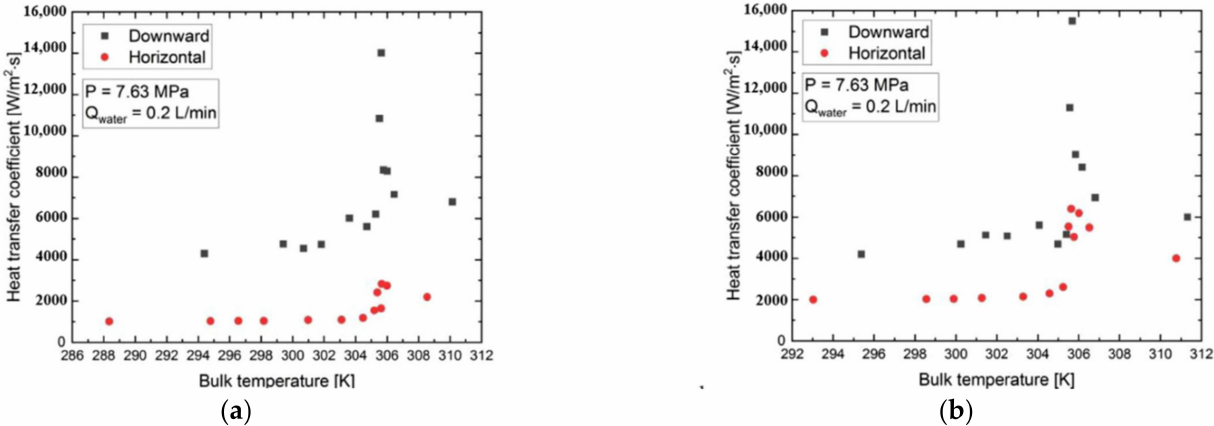
Figure 11. Heat transfer coefficient in different flow directions [38]; ( a ) m CO2 ≈ 1.323 kg/h, ( b ) m CO2 ≈ 2.238